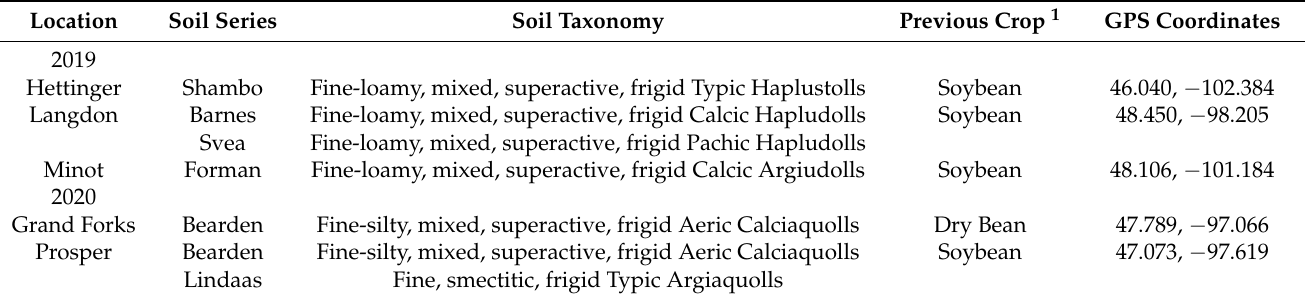
Table 1. Soil series, soil taxonomy, previous crop, and location of the 2019 and 2020 experiment